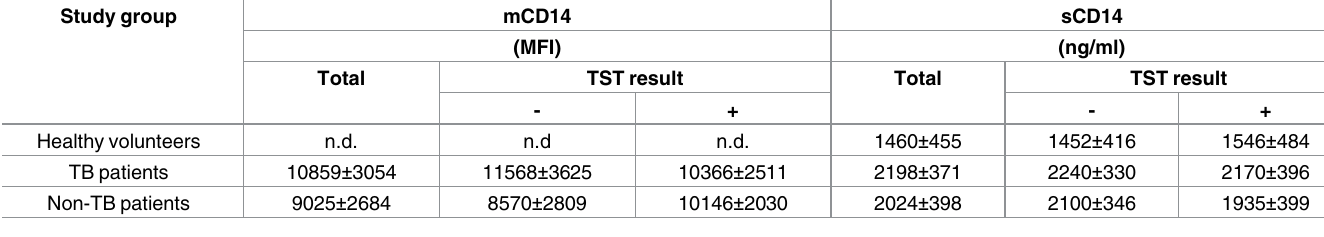
Table 7. Monocyte mCD14 expression and serum sCD14levels in TST(-) and TST(+) individuals. Study group